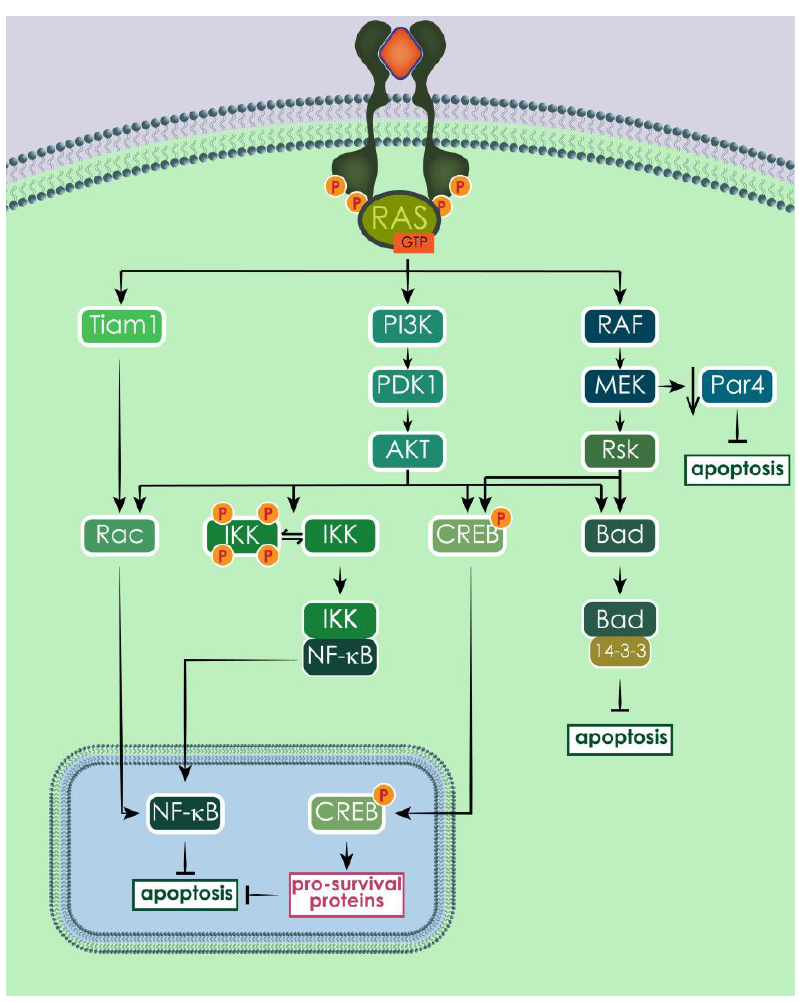
Figure 10. Human RAS proteins protect the cells from apoptosis mainly through the activation of